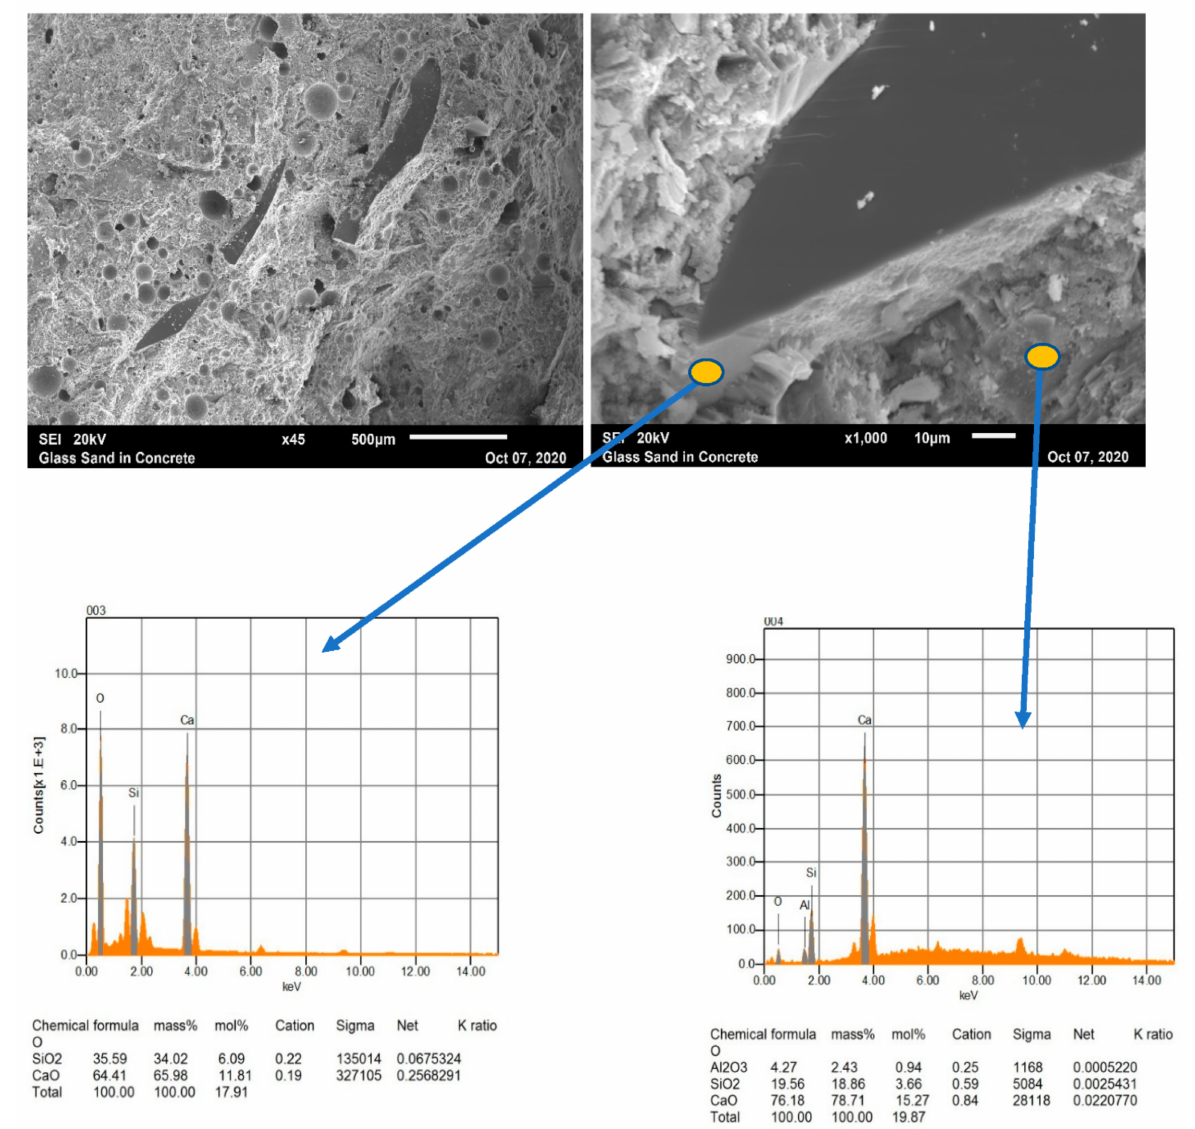
Figure 17. Glass-mortar interfacial zone with alkaline silica reaction (ASR) cracking. Accompanying EDS point probe indicate an Na-Si-Ca ratio consistent with compositions of ASR in lime